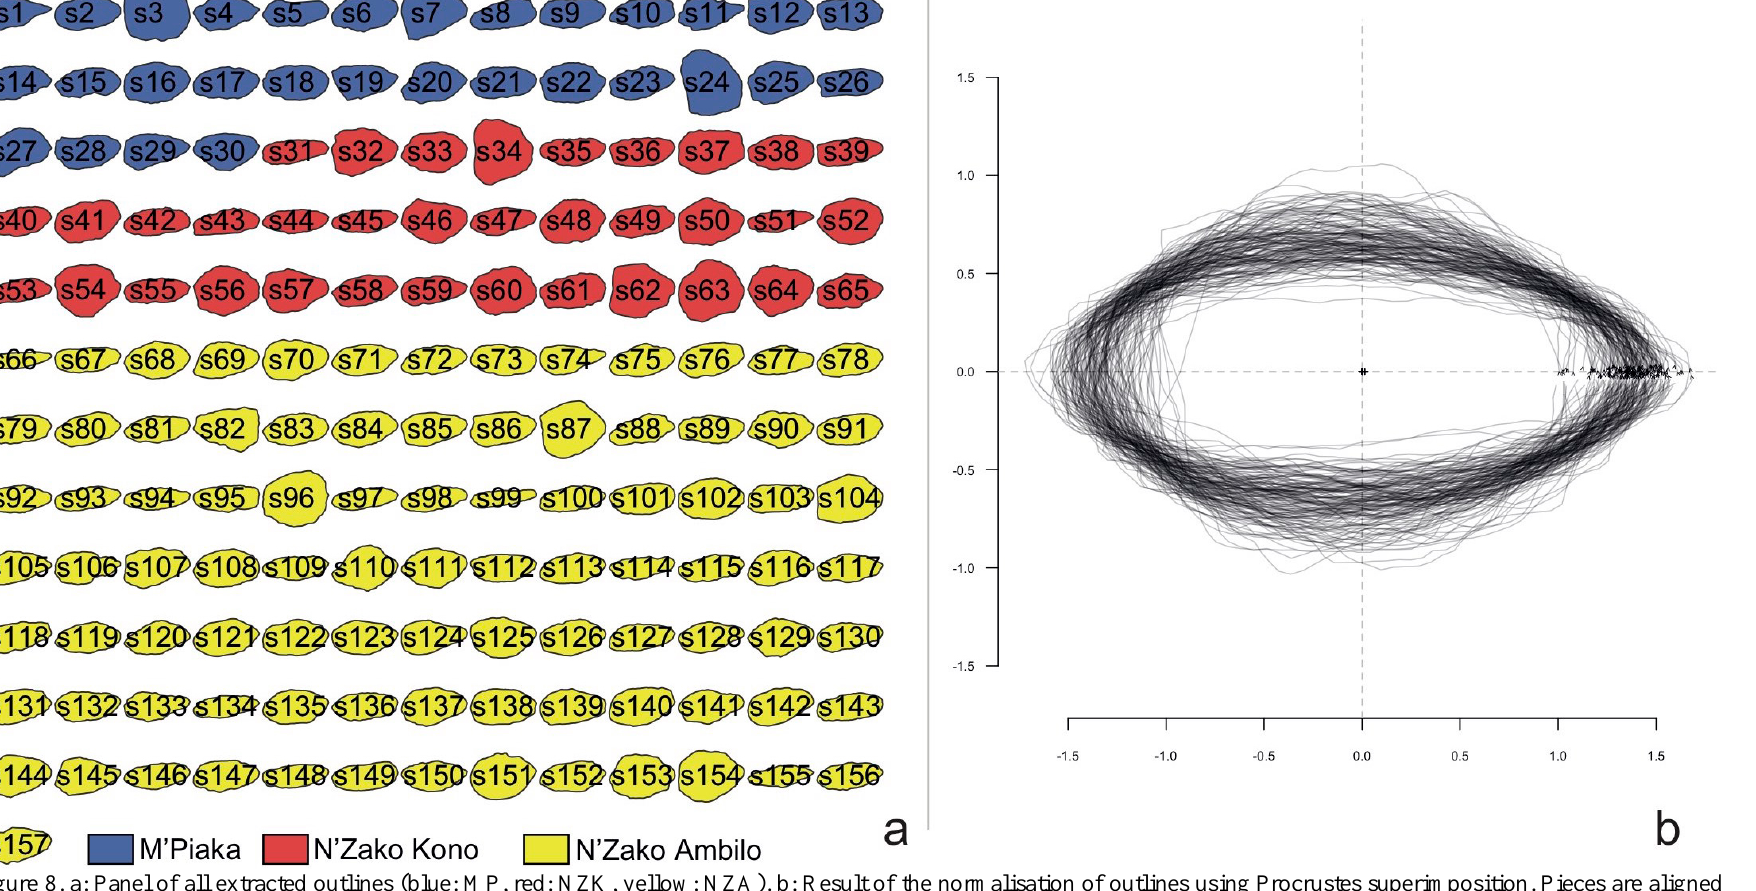
Figure 8. a: Panel of all extracted outlines (blue: MP, red: NZK, yellow: NZA). b: Result of the normalisation of outlines using Procrustes superimposition. Pieces are aligned along the